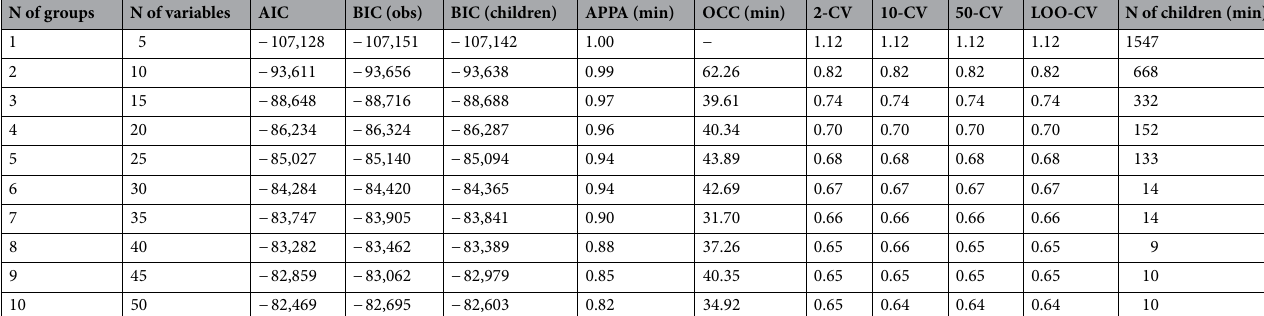
Table 2. Indices used for determining a suitable number of groups. The full models were fitted based on N = 61,398 observations on 1547 children. AIC = Akaike Information Criterion; APPA = Average Posterior Probability of Assignment; BIC = Bayesian Information Criterion; OCC = Odds of correct classification; K-CV = we employed k-fold cross-validation where we randomly split the dataset (on the child level) into k parts, fitted the model on k − 1 parts and evaluated the fit (prediction) on the remaining kth part of the data(33). We chose k as 2, 10 and 50 as well as leave-one-out (LOO-CV) cross-validation where each observation (child) was left out in turn. We used one random split of the data for k = 2, 10 and